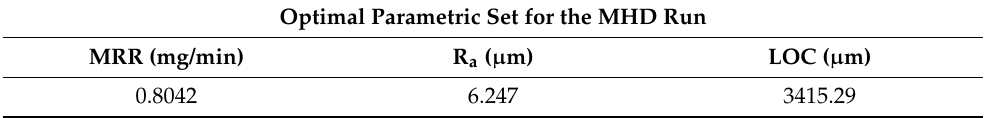
Table 11. Additivity test for the optimal parametric